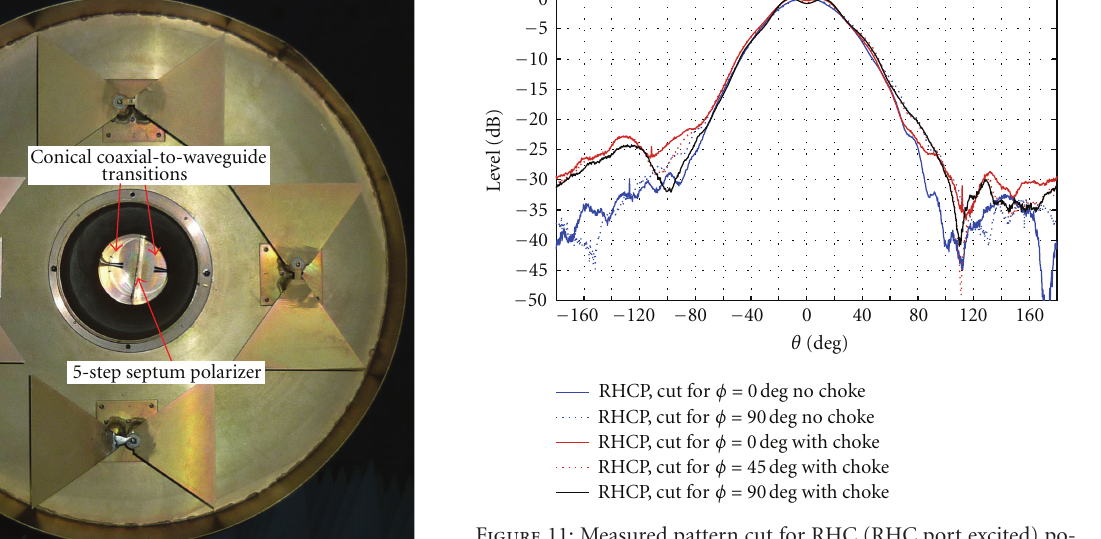
Figure 11: Measured pattern cut for RHC (RHC port excited) po- larization without and with 432 MHz section, working as a choke.